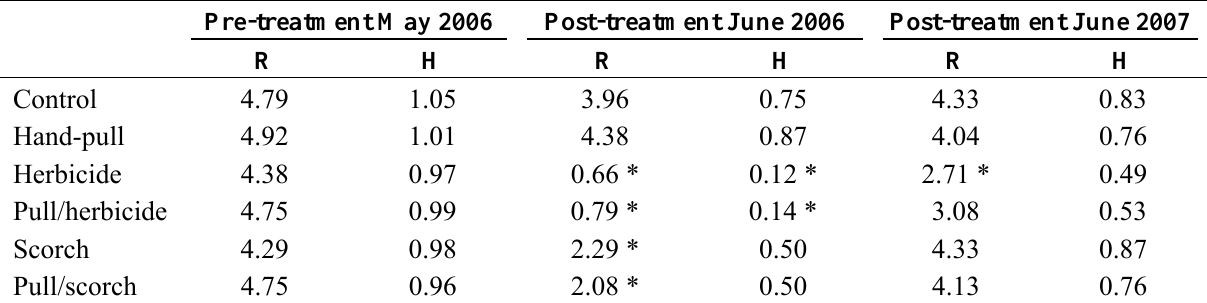
Table 1. Mean understory plant species richness (R) and Shannon’s Diversity (H) before and after treatments aimed at reducing the abundance of garlic mustard. Treatments that significantly differed from the control ( p ≤ 0.05) are indicated by